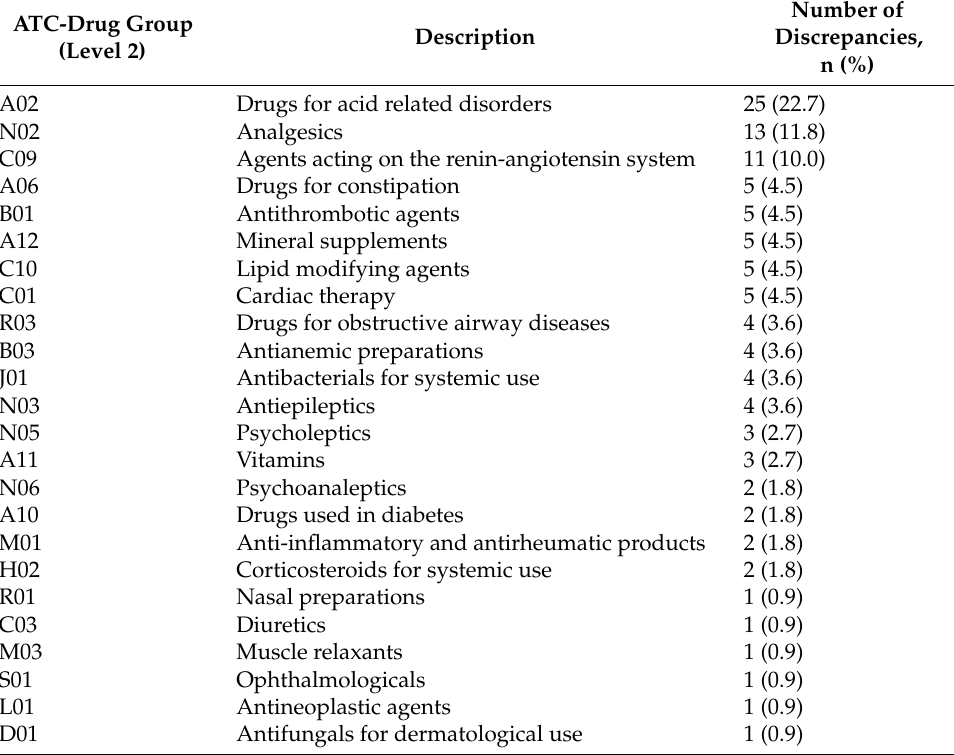
Table A1. Distribution of discrepancies categorized by Anatomic Therapeutic Index